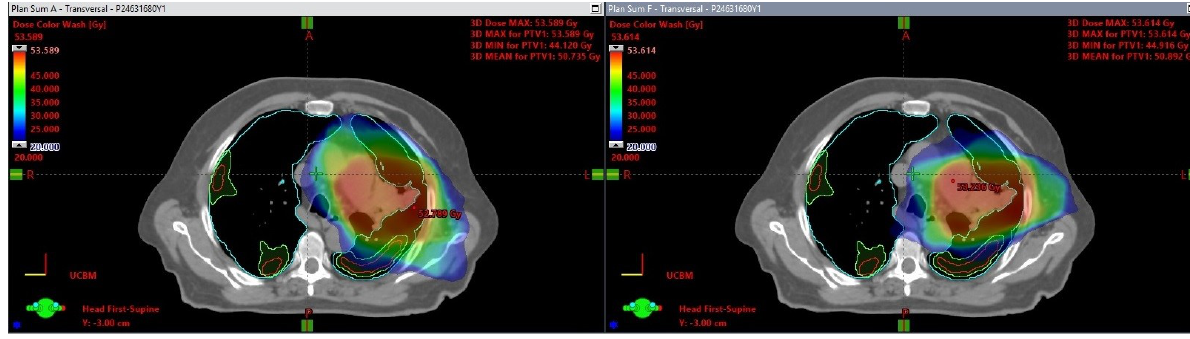
Fig. 2. Comparison of the dose distribution in anatomical plan (left) and in functional plan (right). Three different perfusion areas, based on SPECT intensity, were segmented: low perfusion (blue), medium perfusion (yellow) and high perfusion